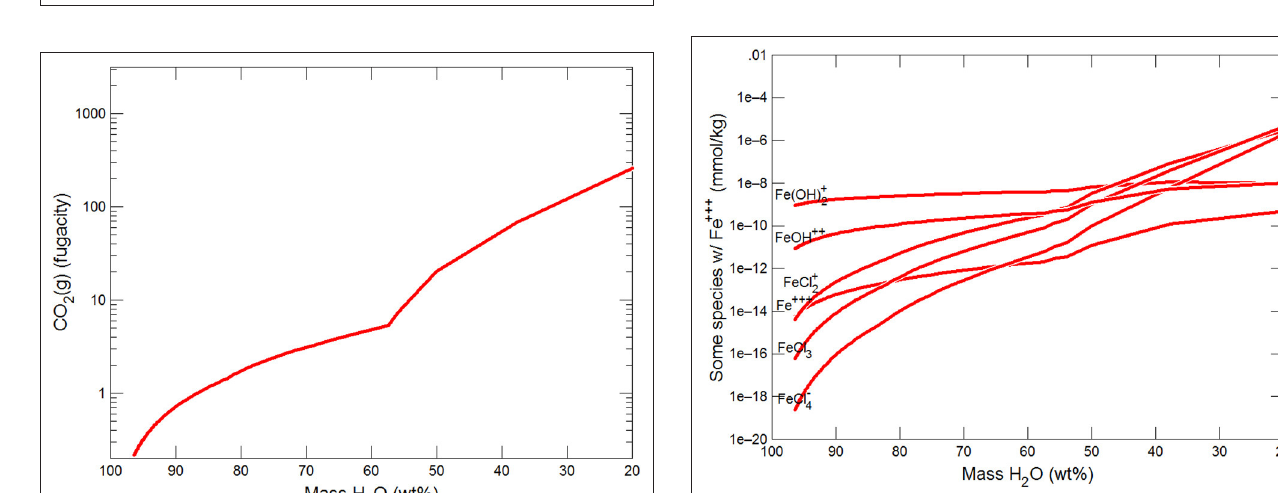
FIGURE 7 | Variations in pH during freezing of seawater.